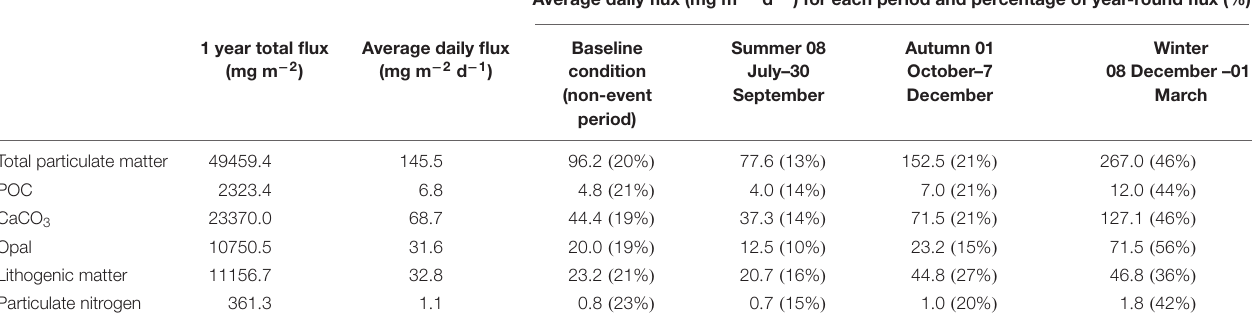
TABLE 1 | Characteristics of seasonal variations of total particles, POC, CaCO 3 , opal, lithogenic matter and particulate nitrogen fluxes observed at SCS-N station during May 2014 to March